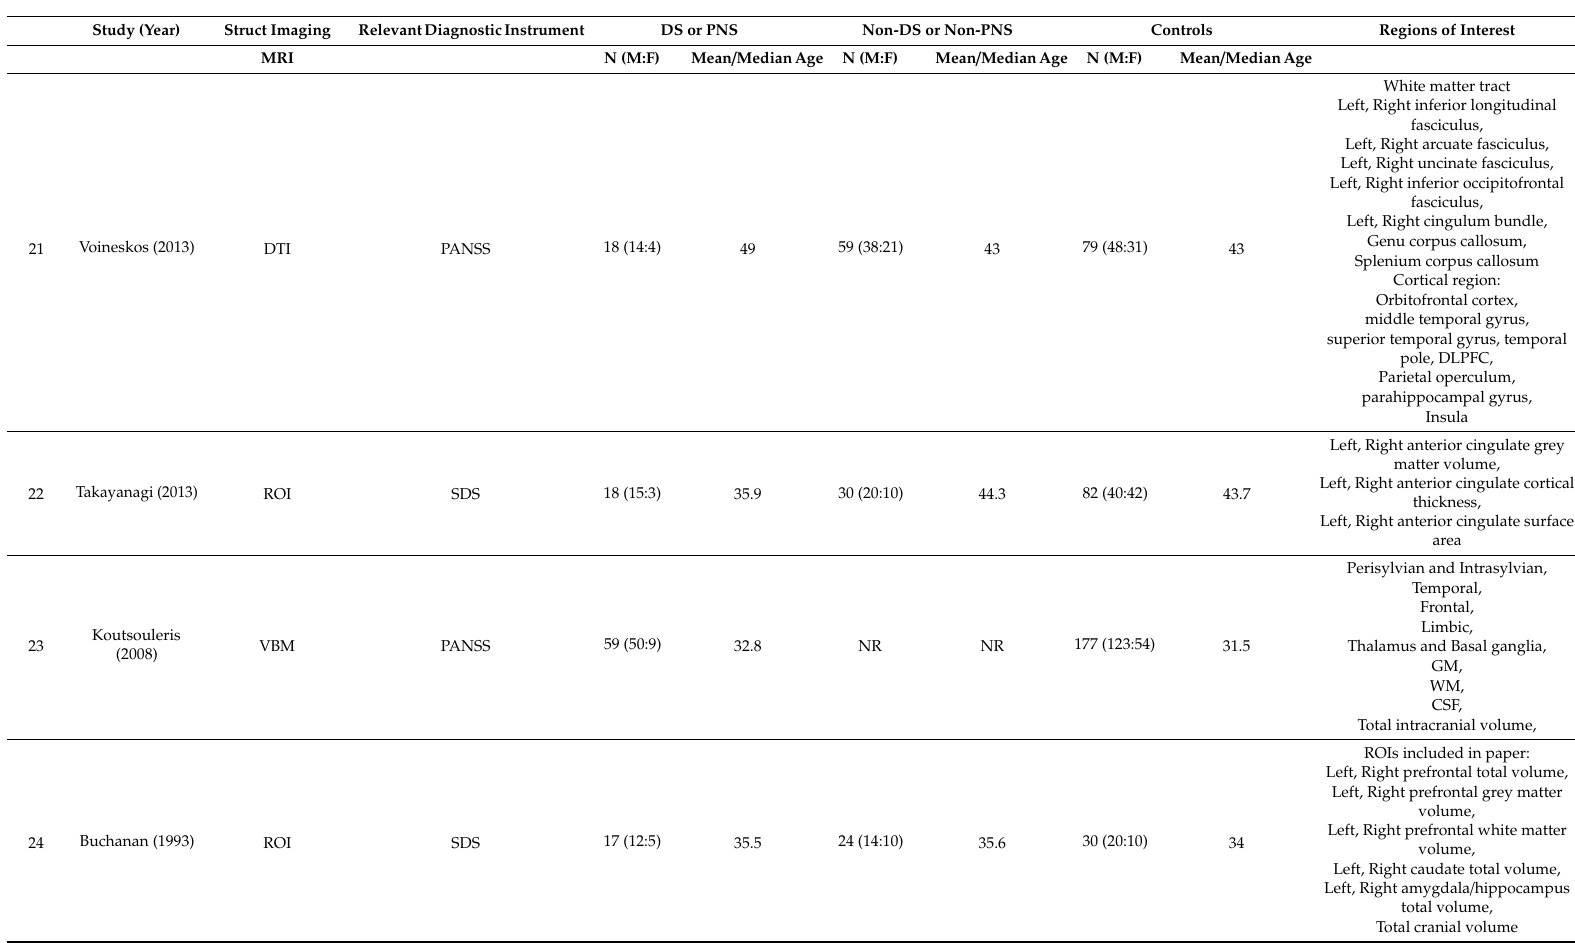
ROIs included in paper: Left, Right prefrontal total volume, Left, Right prefrontal grey matter volume, Left, Right prefrontal white matter 34 volume, Left, Right caudate total volume, Left, Right amygdala / hippocampus total volume, Total cranial